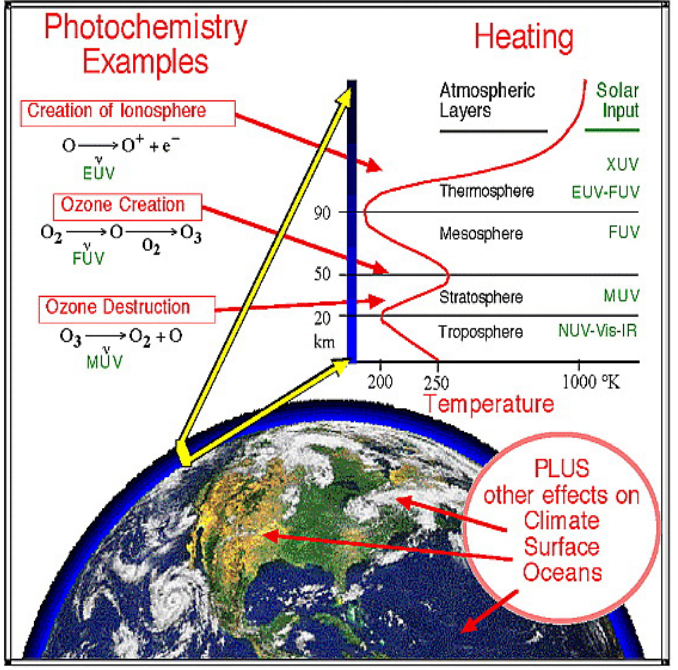
Figure 3. The photochemistry and heating of the atmosphere vary with altitude and the wavelength of solar radiation [9].